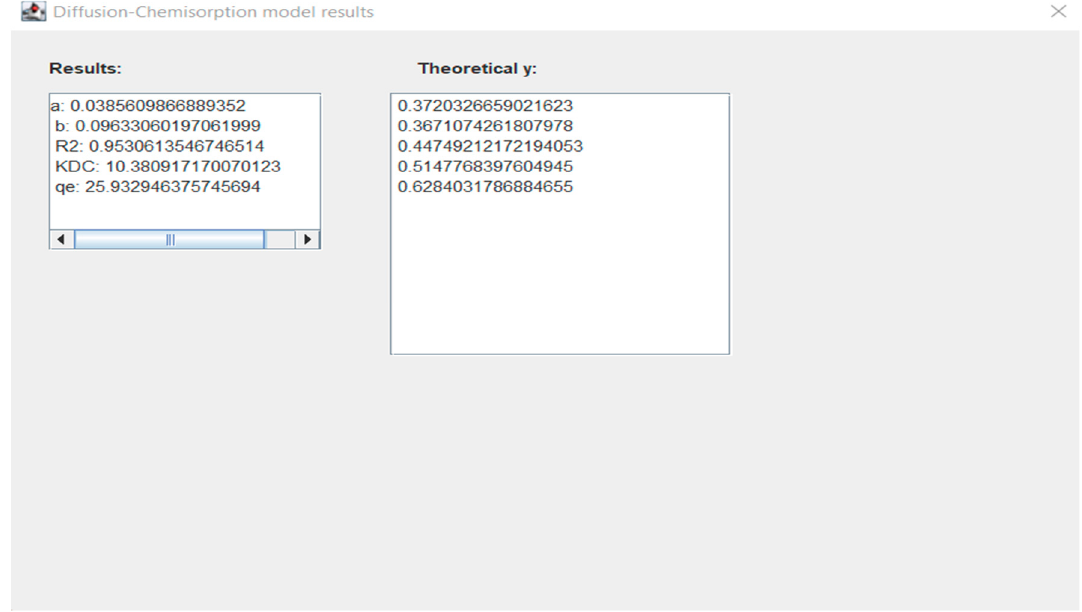
Figure 3. Window with diffusion-chemisorption model results for Eu ions.